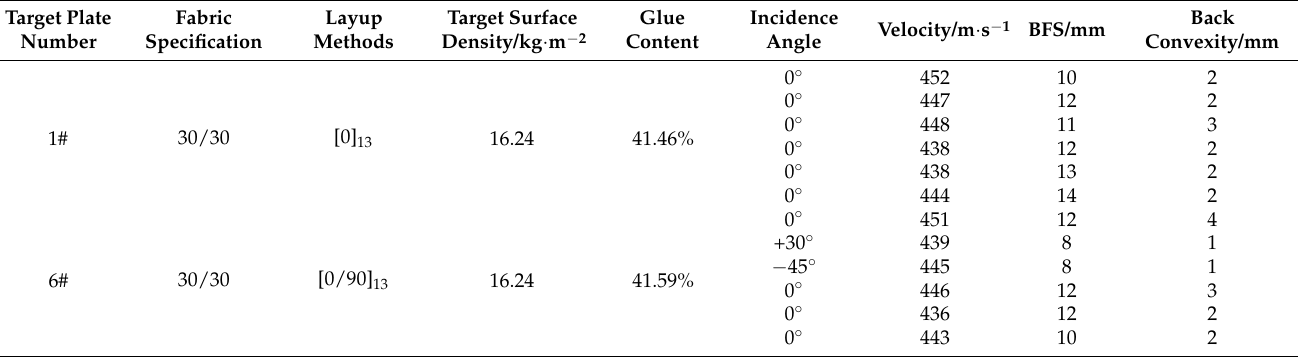
Table 5. Ballistic test results of 3D armor materials under different layup